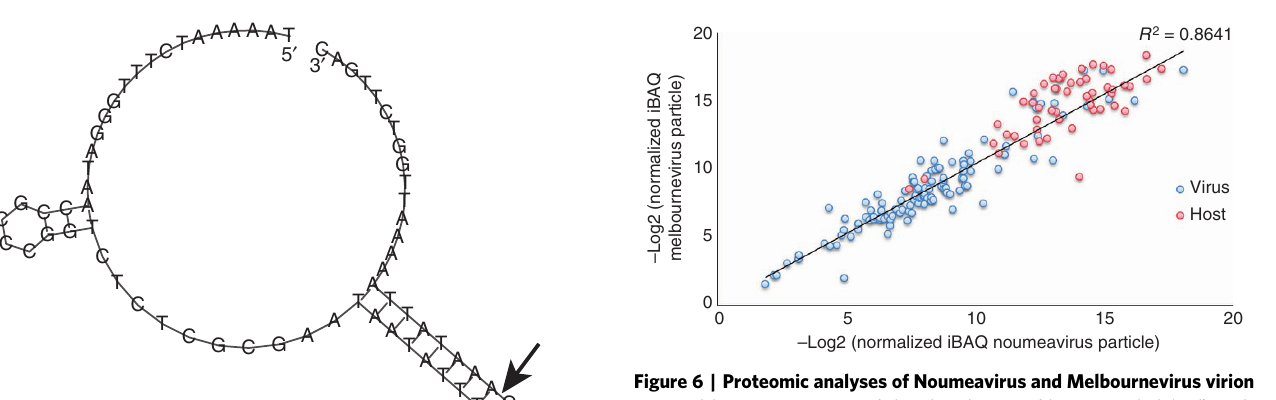
cellular one, except for polyadenylation.